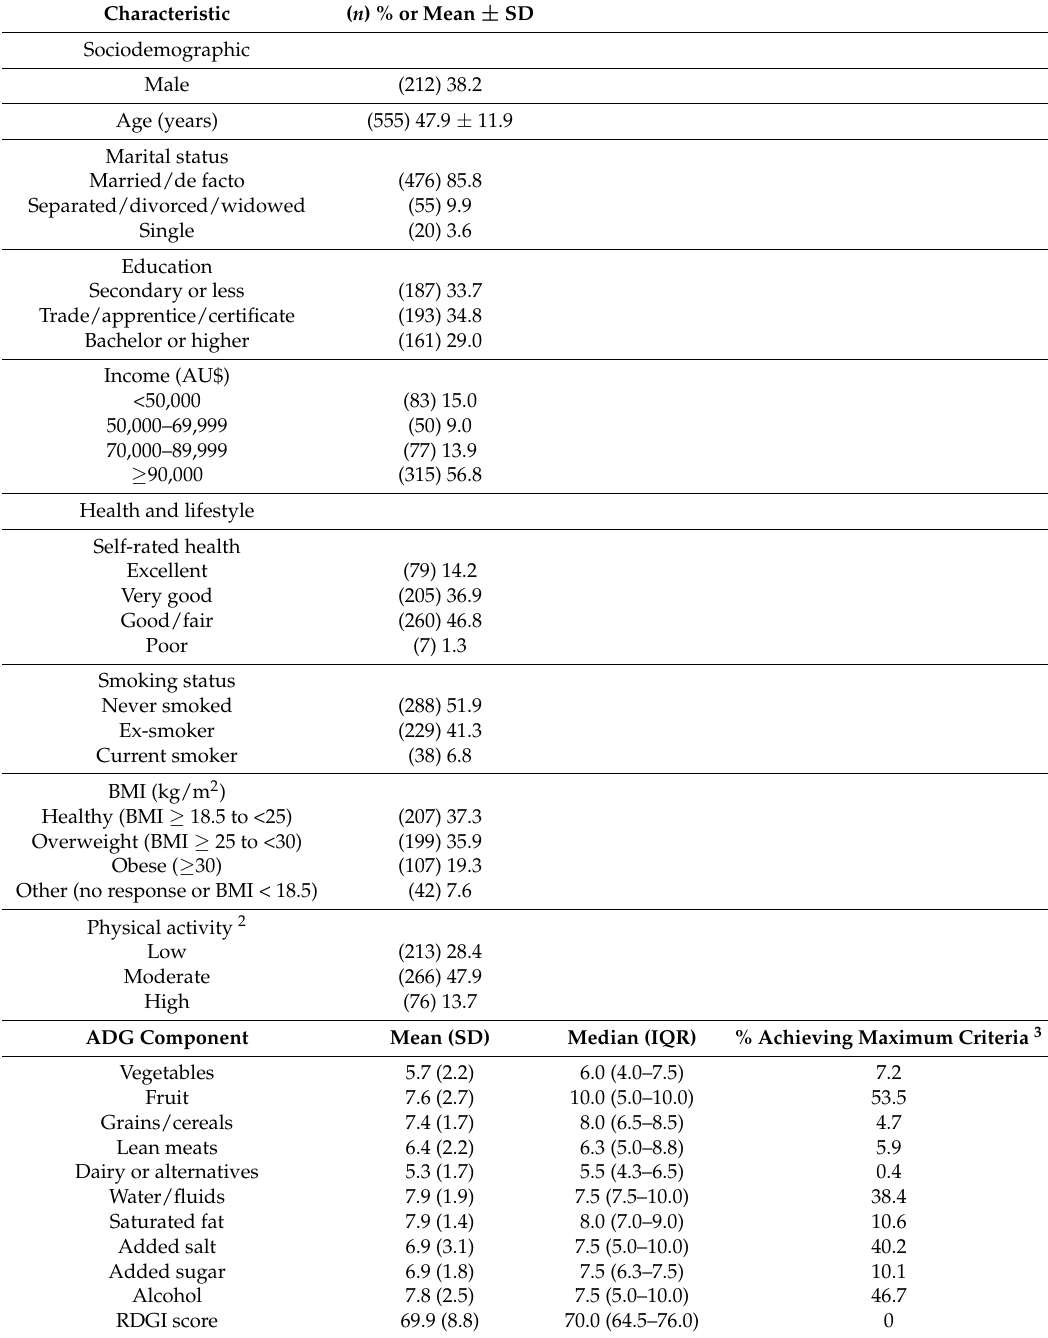
Table 2. Characteristics of RESIDential Environments (RESIDE) study participants at T4 ( n = 555) 1